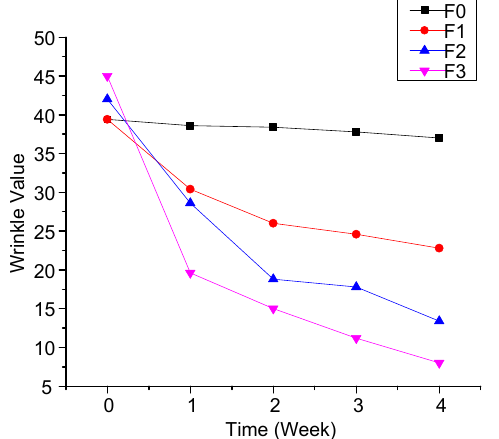
Fig. 4. Graph of the effect of hydrogel eye mask preparation of yellow potato tuber water extract on the wrinkles